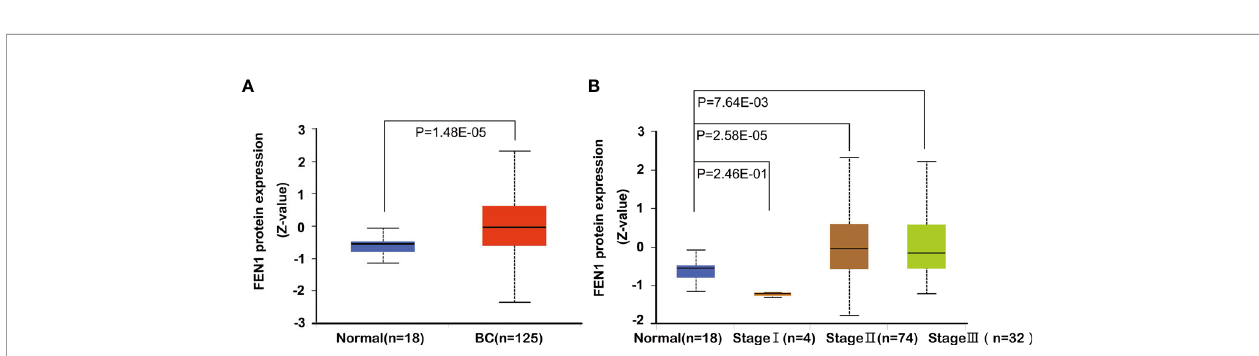
FIGURE 2 | Box plots showing FEN1 expression levels in BC via the UALCAN database analysis. (A) Box plots show FEN1 protein expression levels in normal tissues vs. BC tissues, and (B) in normal tissues vs. BC tissues in different